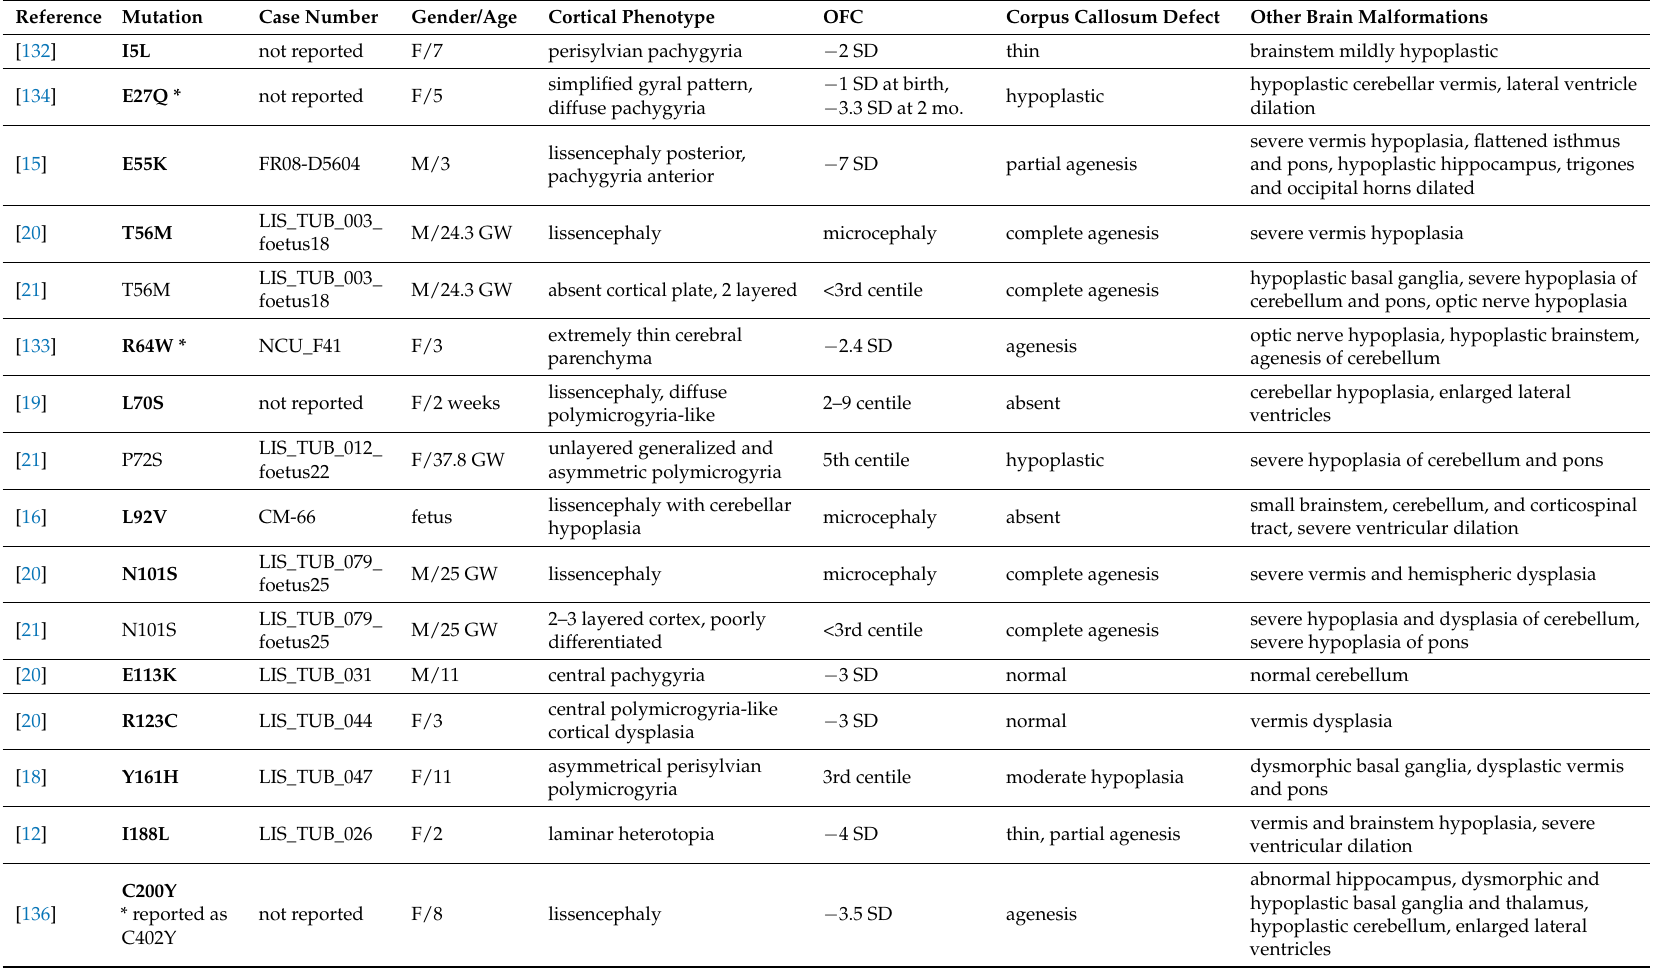
Table 5. Tuba1a mutations leading to microcephaly phenotypes. Microcephaly classified as an OFC more than 2 SD below the appropriate mean (i.e., less than the 3rd